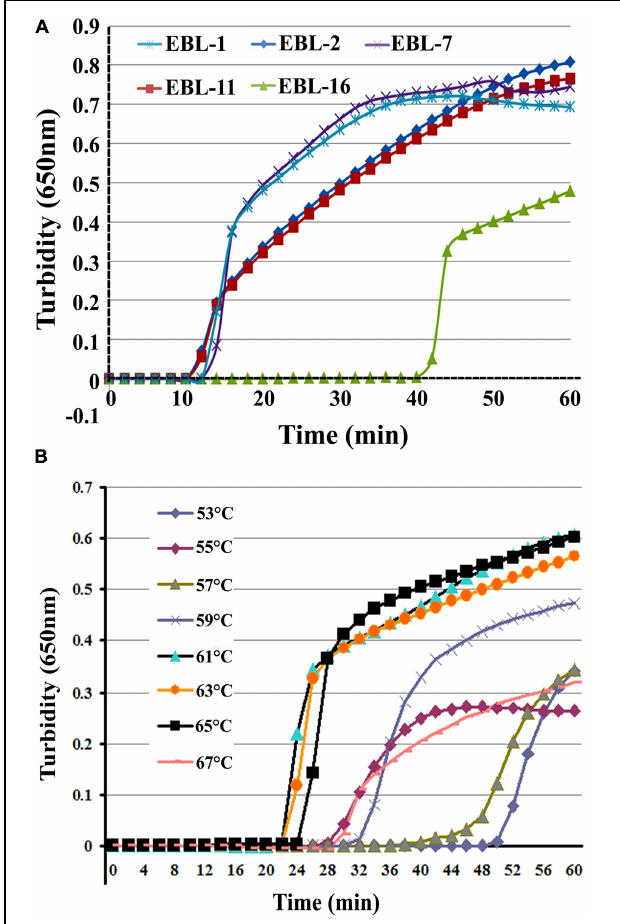
FIGURE 1 | The most appropriate primers and reaction temperatures for the reverse transcription loop-mediated isothermal amplification (RT-LAMP) assay. Turbidity was monitored and recorded every 6 s for five sets of primers used to amplify the target gene with a Loopamp real-time turbidimeter at 650 nm. (A) A total of five sets of primers including EBL-1, EBL-2, EBL-7, EBL-11, and EBL-16 were designed to detect artificial EBOV RNA. (B) Reaction temperatures ranged from 53 to 67 ◦ C with 2 ◦ C intervals.